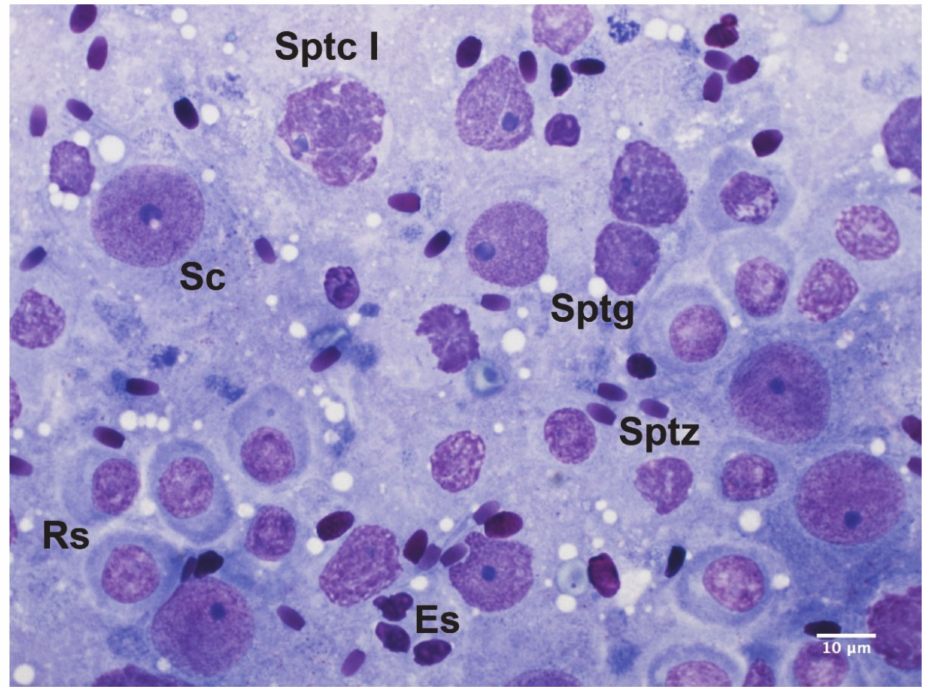
Figure 2. Spermatogenic and Sertoli cells in the tomcat. Sc, Sertoli cell; Sptg, spermatogonium; Sptc I, primary spermatocyte; Rs, round spermatid; Es, elongated spermatid; Sptz, spermatozoon. Hemacolor stain (100 × bright-field